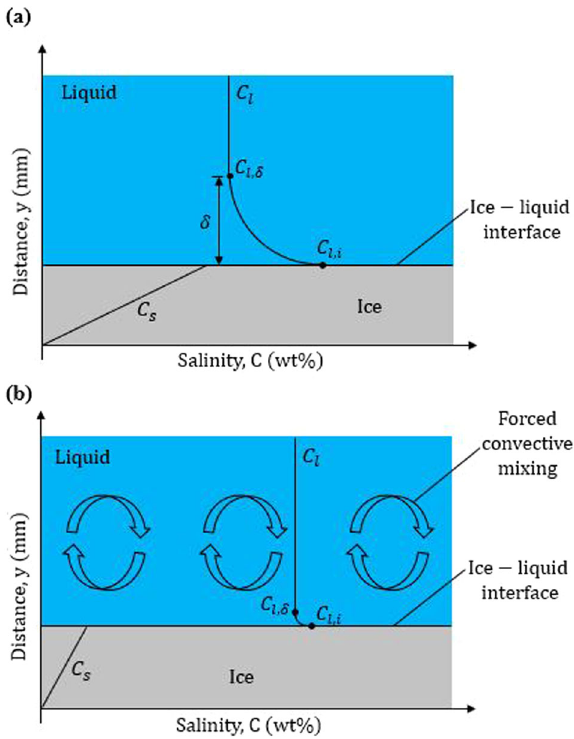
Fig. 1 Schematic of the concentration pro fi les during solidi fi ca- tion of an aqueous mixture. a with diffusional mixing of the rejected solute, b with convective mixing of the rejected solute.